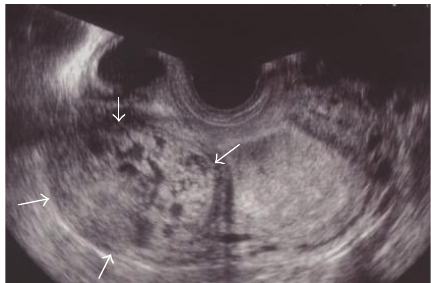
Figure 1: Transvaginal ultrasonographic image at 8 weeks of gestation. A hyperechoic mass (5cm) in the right cornu containing multiple vesicles (arrows).